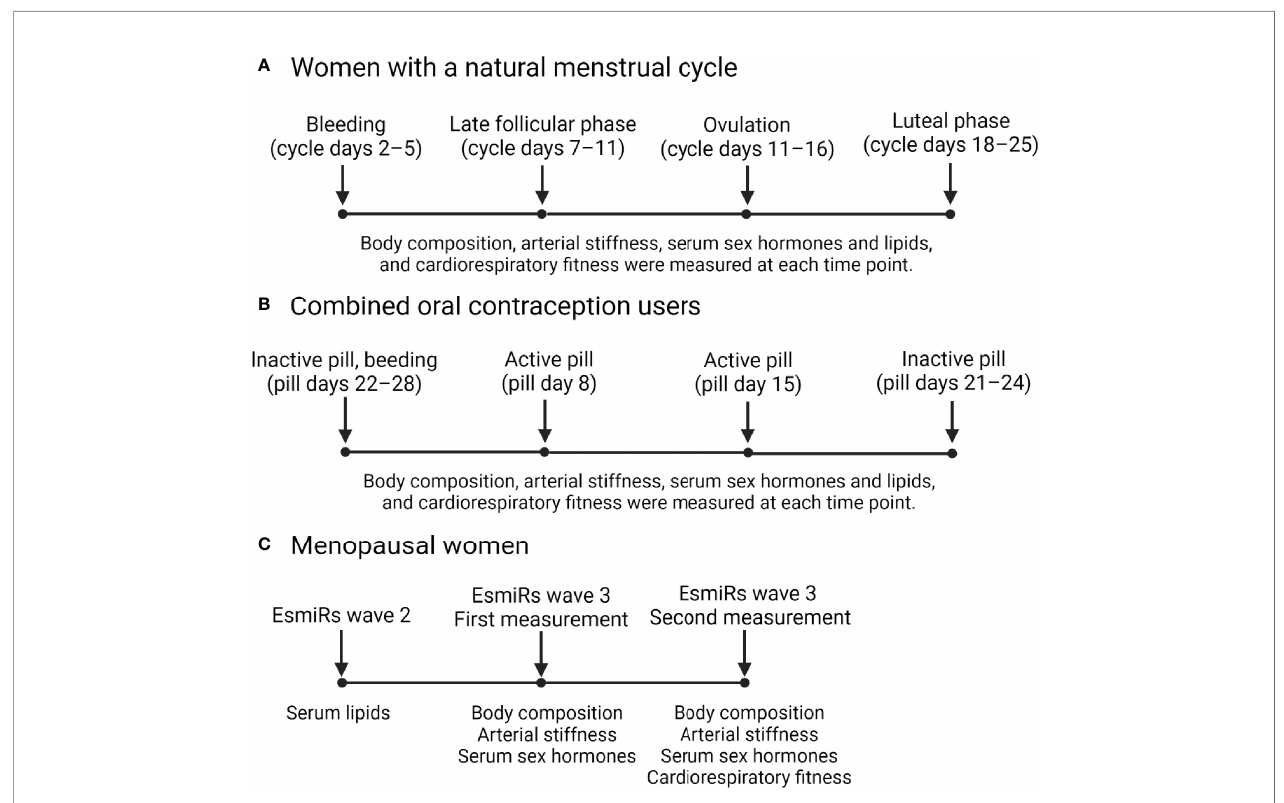
FIGURE 1 | Data collection timepoints in the MEndEx (A, B) and EsmiRs (C)